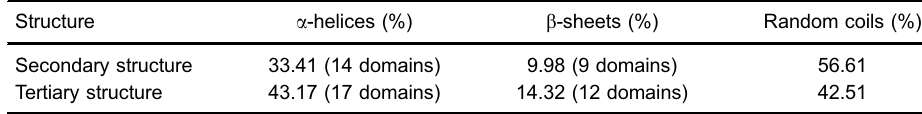
Table 2. Secondary and tertiary structure elements of Der f 33.